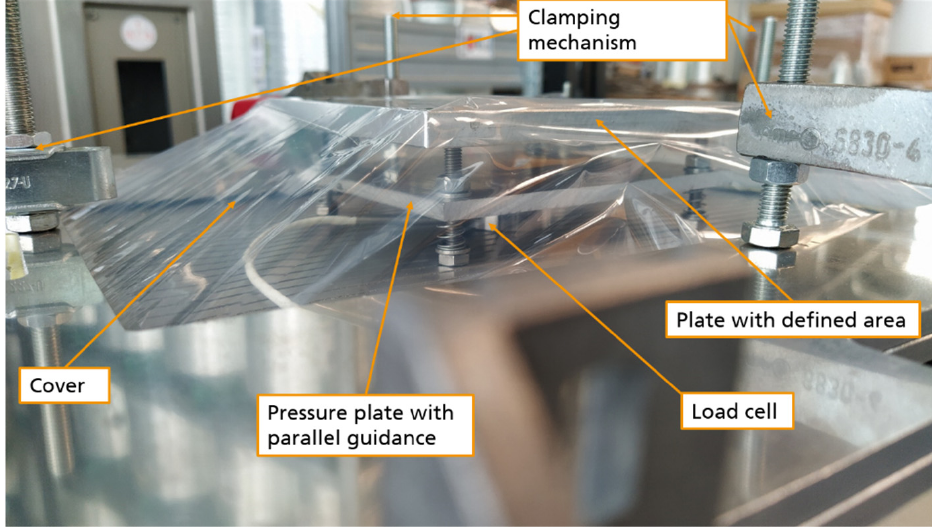
Figure 19. Test setup for the validation of the developed model.